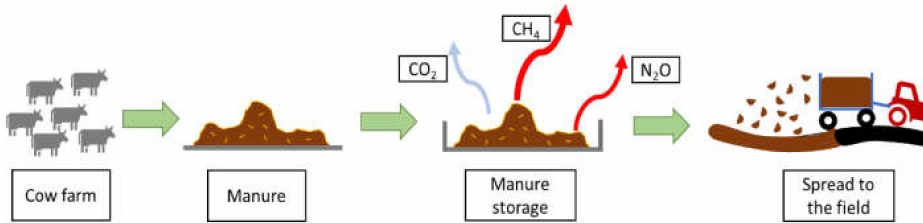
Figure 1. Scheme of Scenario I, manure storage [40].